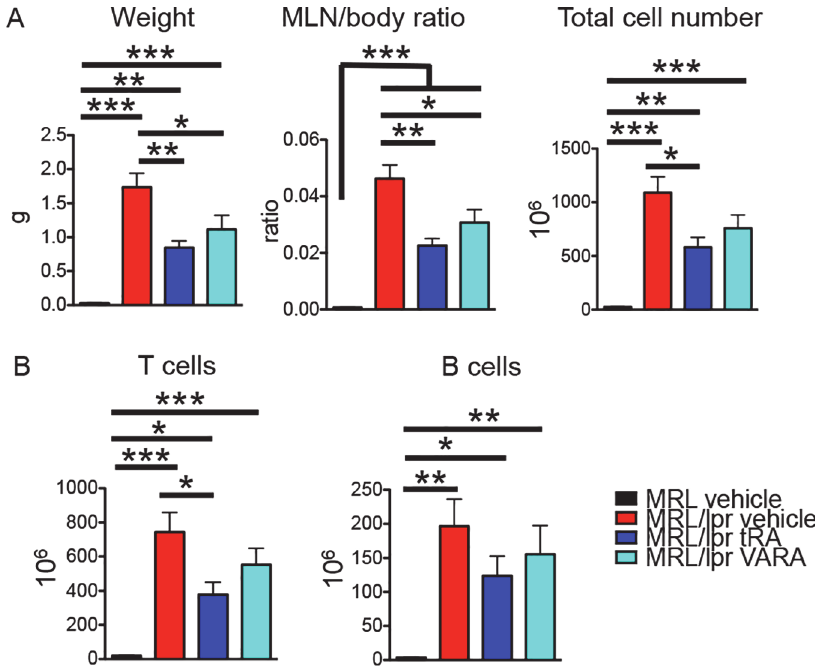
Fig 4. tRA-mediated decrease of lymphocyte accumulation in the MLN. (A) MLN weight, MLN/body weight ratio, and total number of cells in MLN. (B) Absolute numbers of T and B cells in the MLN. * P < 0.05, ** P < 0.01, *** P < 0.001, one-way ANOVA. Data are shown as mean + SEM (n = 6 mice in each